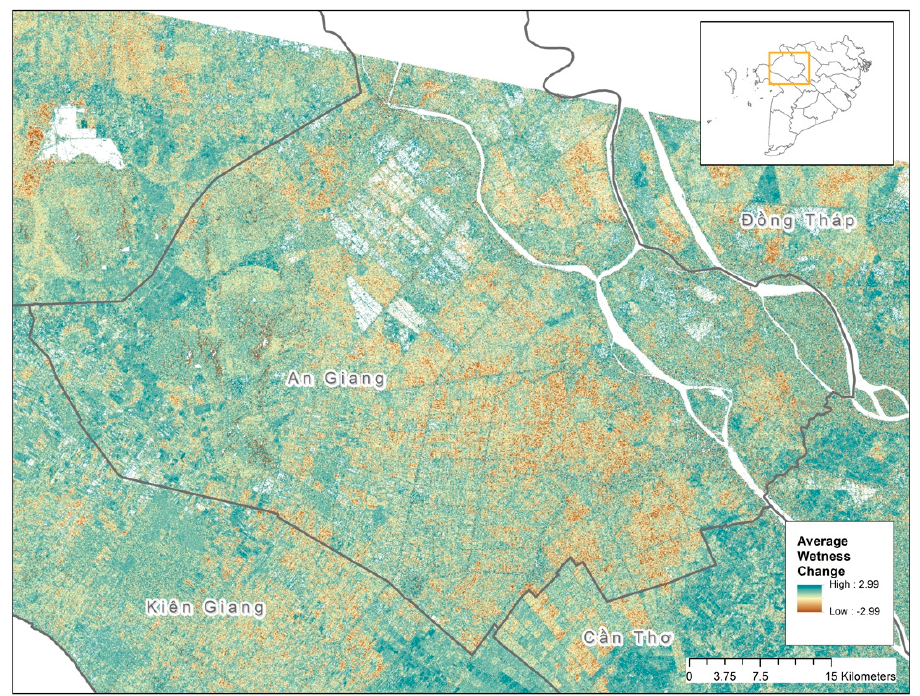
Figure 6. Inland average WI change. The inland pattern of higher dryness averages showing an overall greater occurrence of drying down, or a lower WI score. These results demonstrate that the inland provinces of An Giang and Dong Thap may be adopting AWD at a broader, more uniform rate than the coastal provinces.